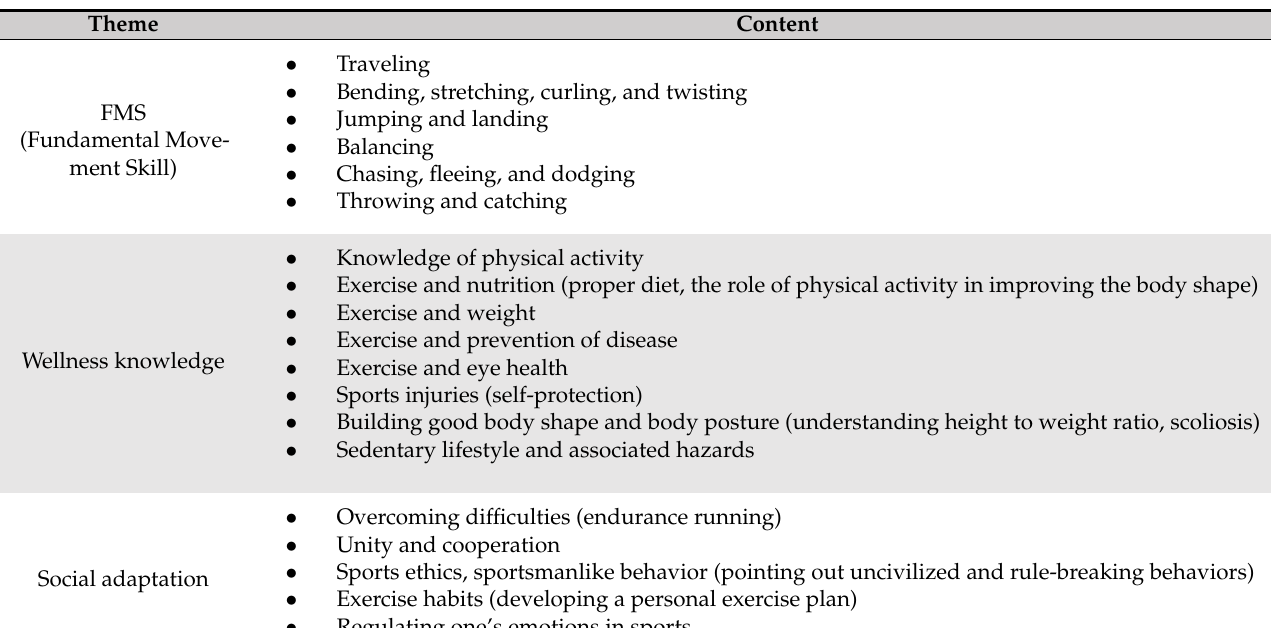
Table 2. Themes and content of the EMWKG